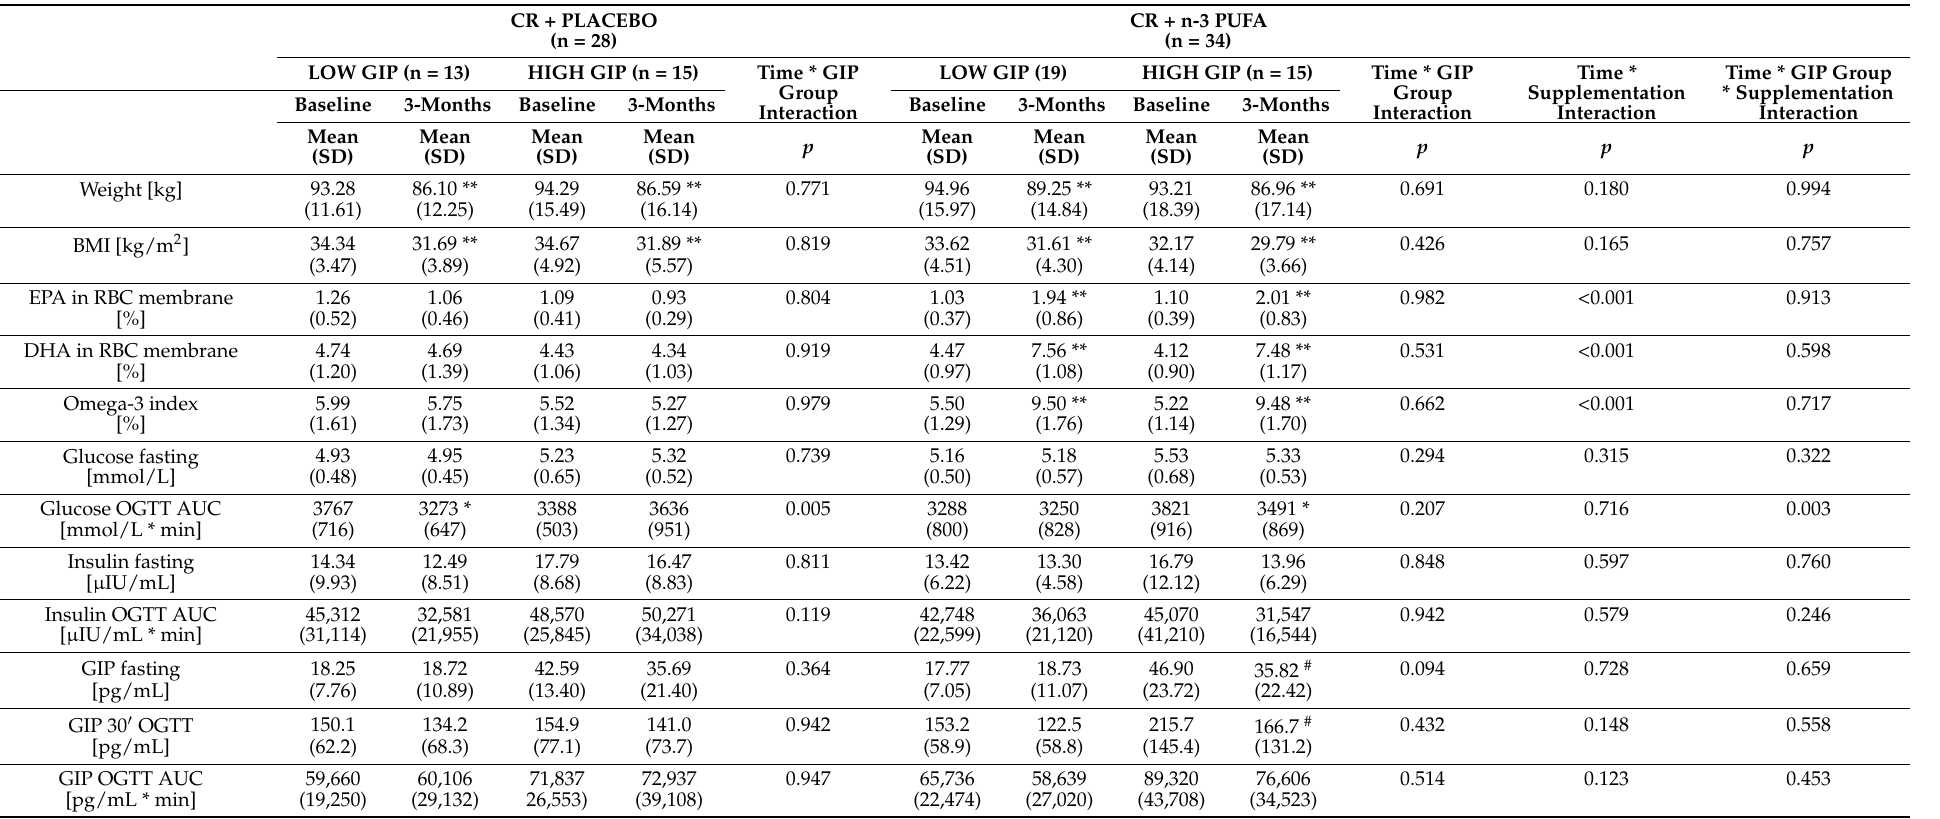
Table 4. Effect of placebo and n-3 PUFA supplementation on anthropometrics, EPA and DHA status and biochemical parameters according to GIP plasma